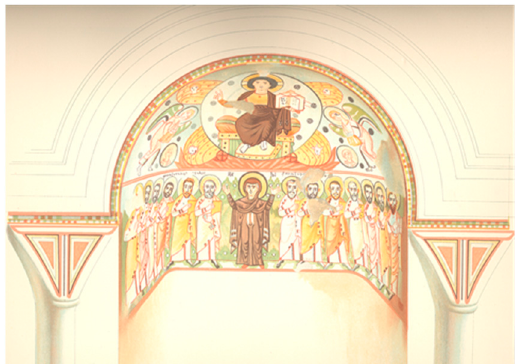
Figure 14. Bawit (Egypt), chapel 17. Aquarelle copy. After Clédat (1904) vol. 1, part two. pl. XLI.